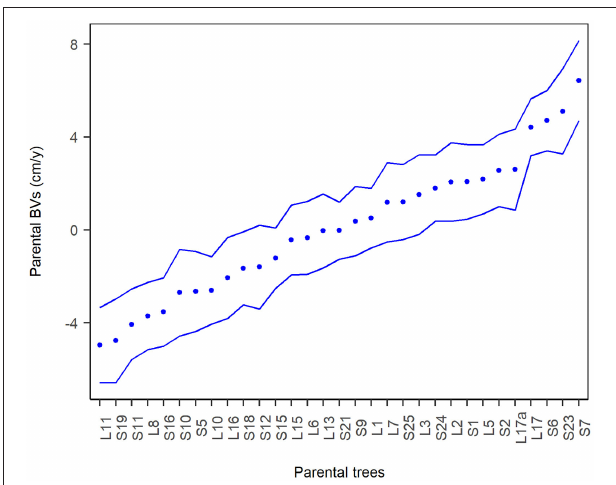
FIGURE 3 | Population RF with R 2 adj of 0.32. PMAIs are plotted against the sites’ MTCM. Boxplot were plotted for each site. The black dots represent the outliers. The gray band represents the curve’s 95 % confidence interval. Sites are from the left to right: B16, B18, B11, B12/B20, B6/B7/B5/B13, W3, B4/B3, A/B9/N, W4, B2/B1/H2, T1/T2 (sites separated by a “/” have the same MTCM but are plotted next to each other for a clearer